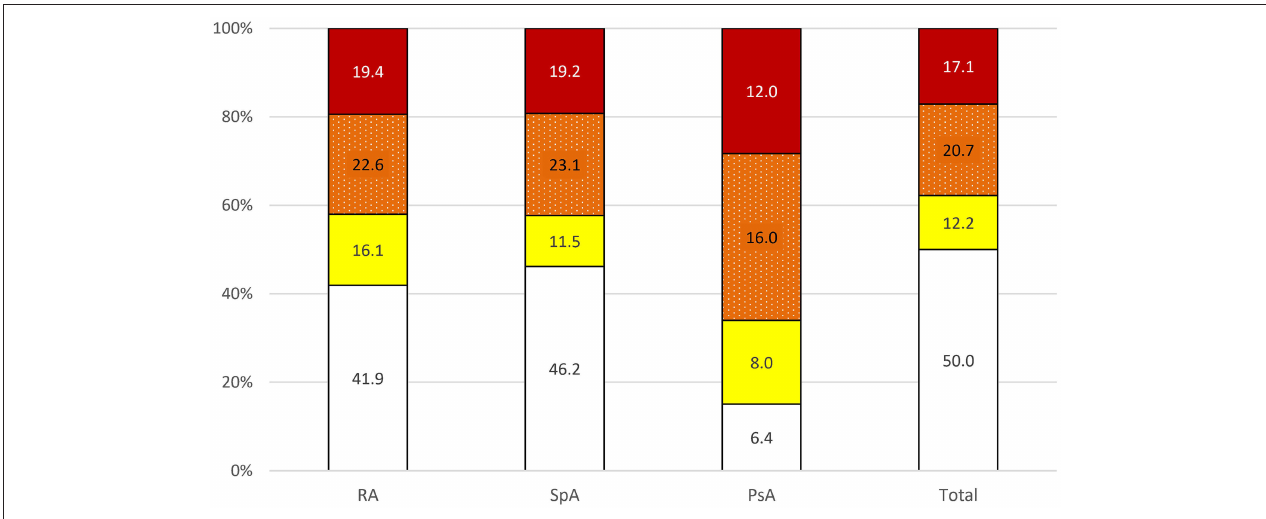
FIGURE 2 | Risk of 10-year cardiovascular mortality in all patients with IJD aged 40 to 65 years according to 2016 ESC guidelines on cardiovascular disease prevention ( low, moderate, high, and very high risk; data given in percentages). PsA, psoriatic arthritis; RA, rheumatoid arthritis; SpA, spondyloarthritis.